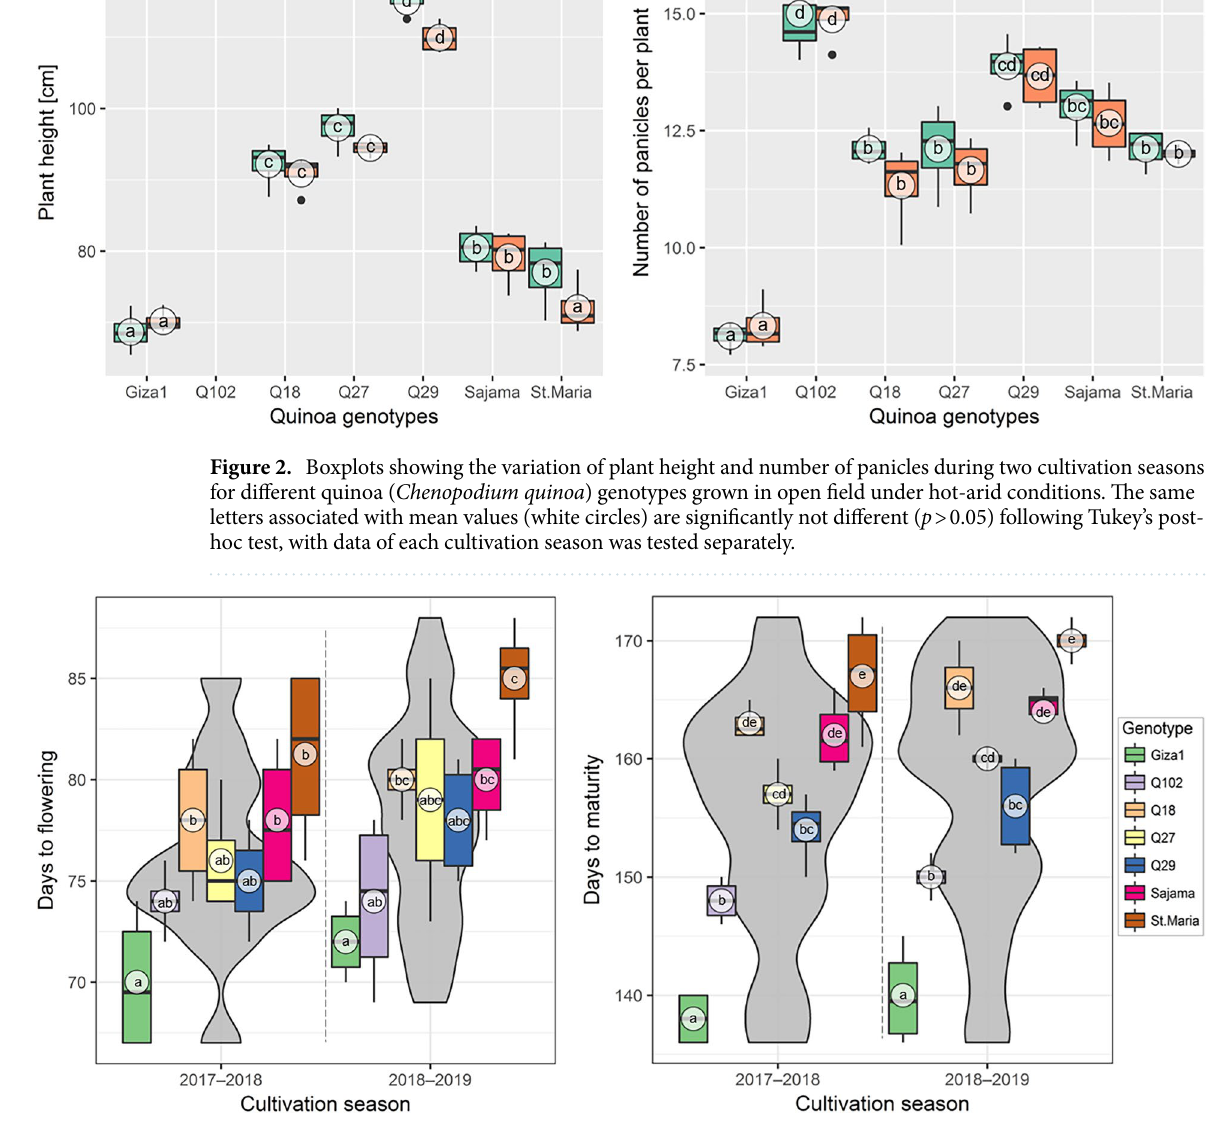
Figure 3. Boxplots overlaid on violin plots showing flowering and maturation periods during two cultivation seasons for different quinoa ( Chenopodium quinoa ) genotypes grown in open field under hot-arid conditions. The same letters associated with mean values (white circles) are significantly not different ( p > 0.05) following Tukey’s post-hoc test, with data of each cultivation season was tested